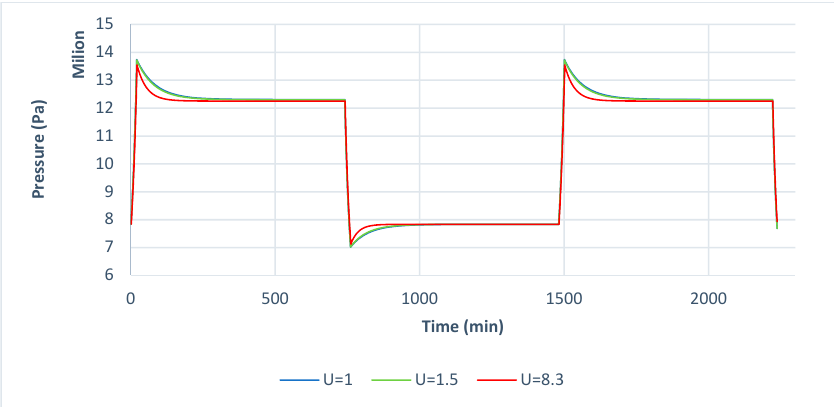
Figure 13. Gas temperature trend for the Second Configuration varying the Transmittance of the tank. Energies 2018 , 11 , 3405